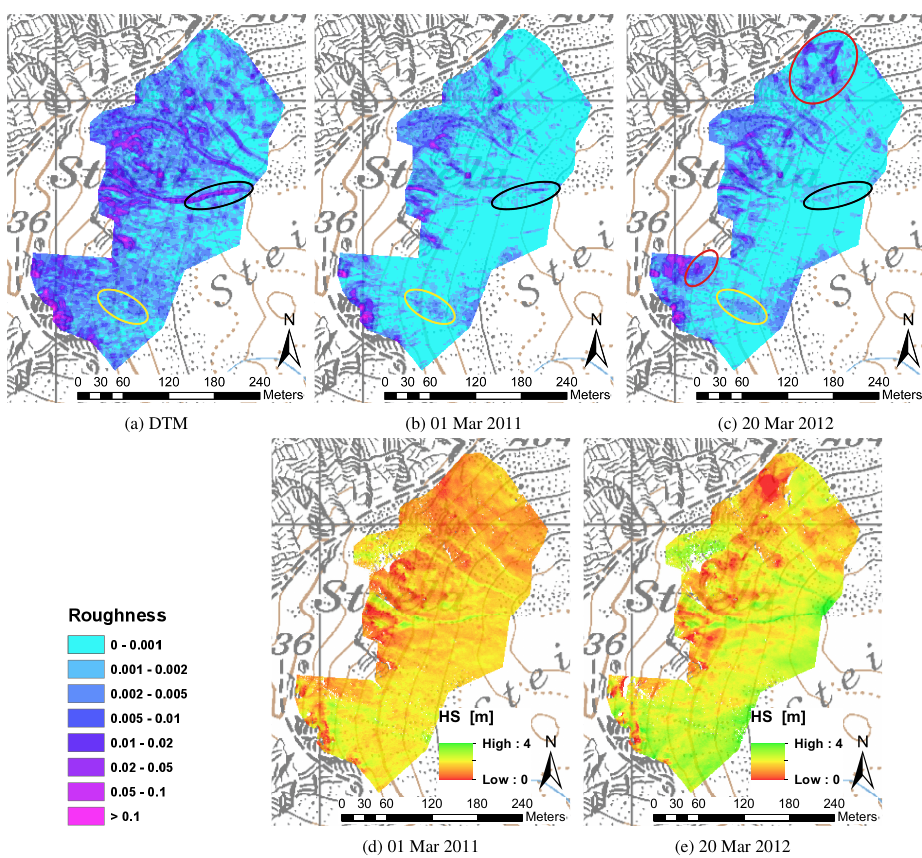
Fig. 11. (a) Surface roughness of summer terrain and (b, c) winter terrain at a scale of 5m in the basin ST. (d, e) show the corresponding snow depth distributions. The black and yellow circles show persistent smoothing features. Red circles show the location of glide cracks. Pixmaps © 2013 swisstopo (5704 000 000). Table 5. Coefficient of determination ( R 2 ) of correlations between snow depth distributions in the ST basin ( p < 0.0001).